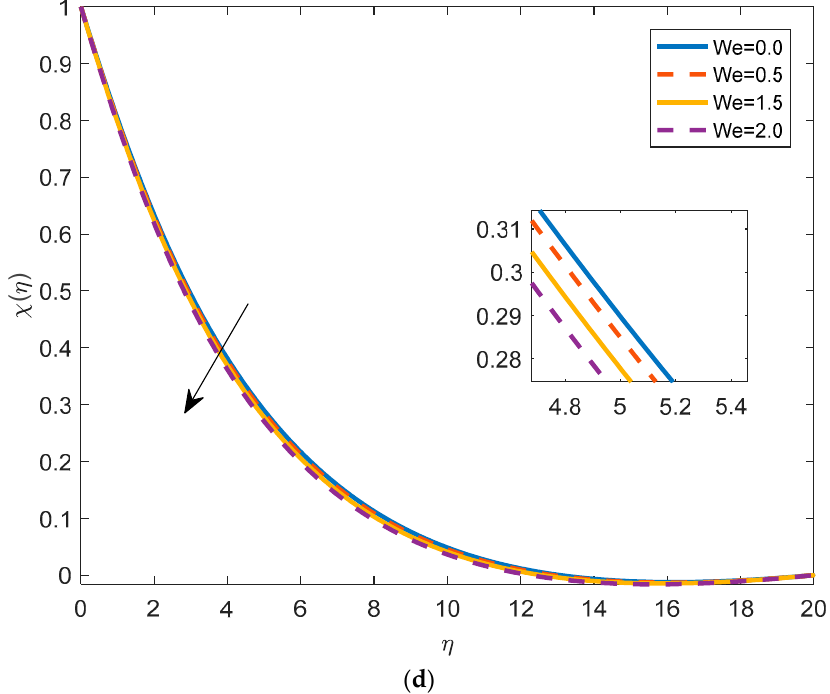
Figure 7. ( a ): Velocity distribution for various W e when Nt = 0.1, Nb = 2.0, M = 1.0, Pr = 1.5, R b = 0.1, λ = 0.2, Sc = 0.5, Sc n = 0.5, Pe = 1.0, K p = 0.5 at α = π /6. ( b ): Temperature distribution for various W e when Nt = 0.1, Nb = 2.0, M = 1.0, Pr = 1.5, Rb = 0.1, λ = 0.2, Sc = 0.5, Sc n = 0.5, Pe = 1.0, K p = 0.5 at α = π /6. ( c ): Concentration distribution for various W e when Nt = 0.1, Nb = 2.0, M = 1.0, Pr = 1.5, Rb = 0.1, λ = 0.2, Sc = 0.5, Sc n = 0.5, Pe = 1.0, K p = 0.5 at α = π /6. ( d ): Density of motile micro-organisms for various W e when Nt = 0.1, Nb = 2.0, M = 1.0, Pr = 1.5, Rb = 0.1, λ = 0.2, Sc = 0.5, Sc n = 0.5, Pe = 1.0, K p = 0.5 at α = π /6.